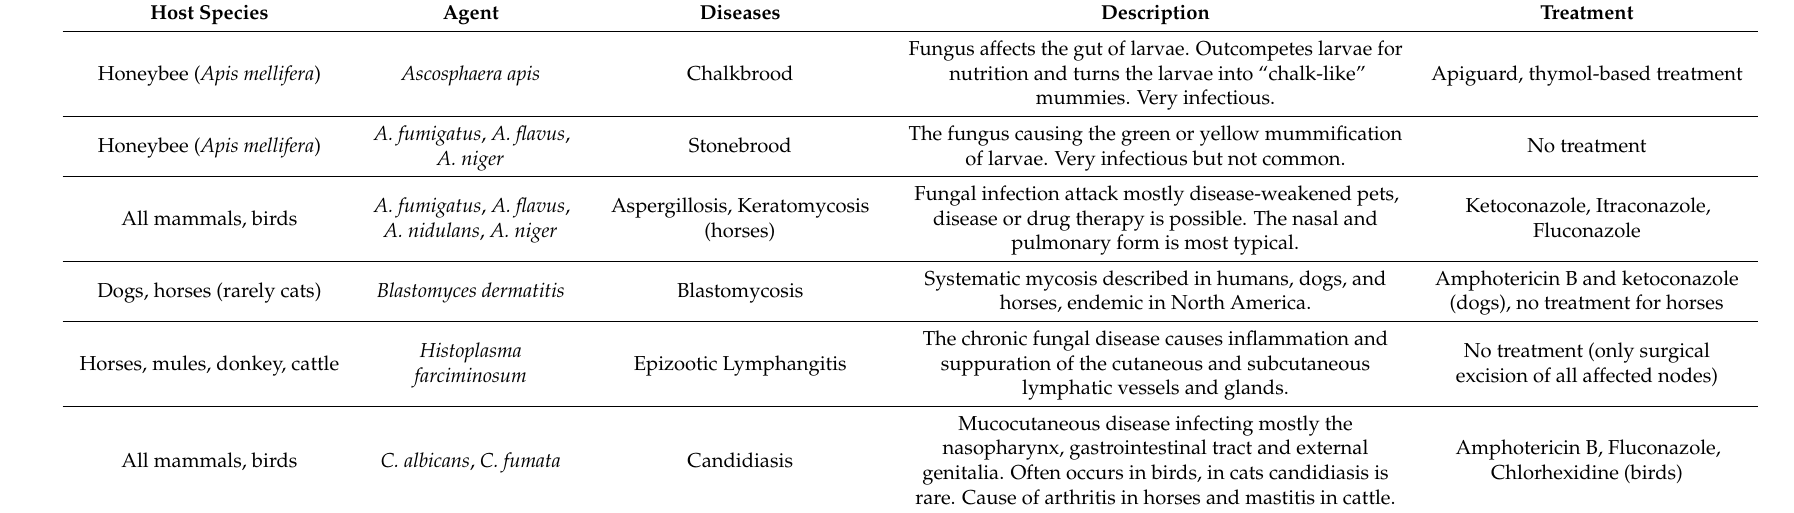
Table 1. Common fungal diseases in animals. Sources: https://www.msdvetmanual.com and